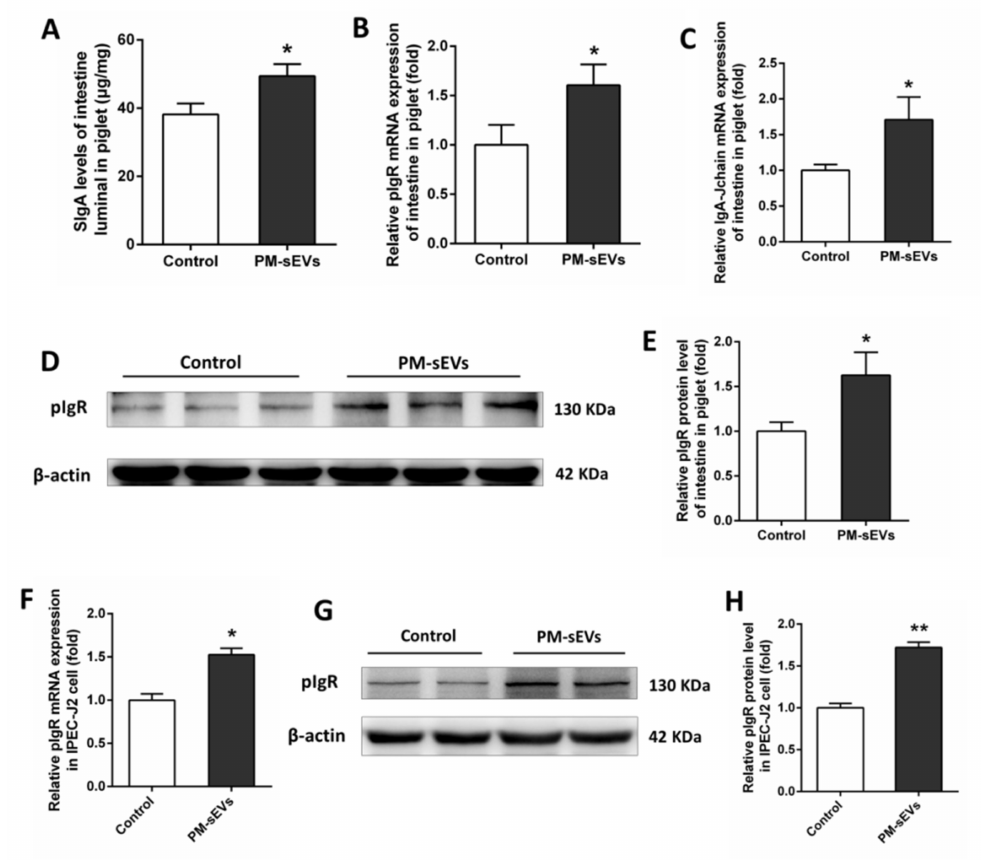
Figure 2. PM-sEVs promote intestinal SIgA levels in piglets and influence relevant gene expression in piglet intestine and IPEC-J2 cells. ( A ) ELISA analysis of SIgA levels of intestinal luminal contents in piglets ( n = 6). ( B , C ) qRT-PCR analysis of IgA-Jchain, pIgR mRNA expression levels of intestinal tissue in piglets ( n = 6). ( D , E ) Western Blotting analysis of pIgR protein level of intestinal tissue in piglets ( n = 3). ( F ) qRT-PCR analysis of pIgR mRNA expression levels in IPEC-J2 cell ( n = 6). ( G , H ) Western Blotting analysis of pIgR protein levels in IPEC-J2 cell ( n = 4). All data are presented as means ± SEM. * p < 0.05; ** p <